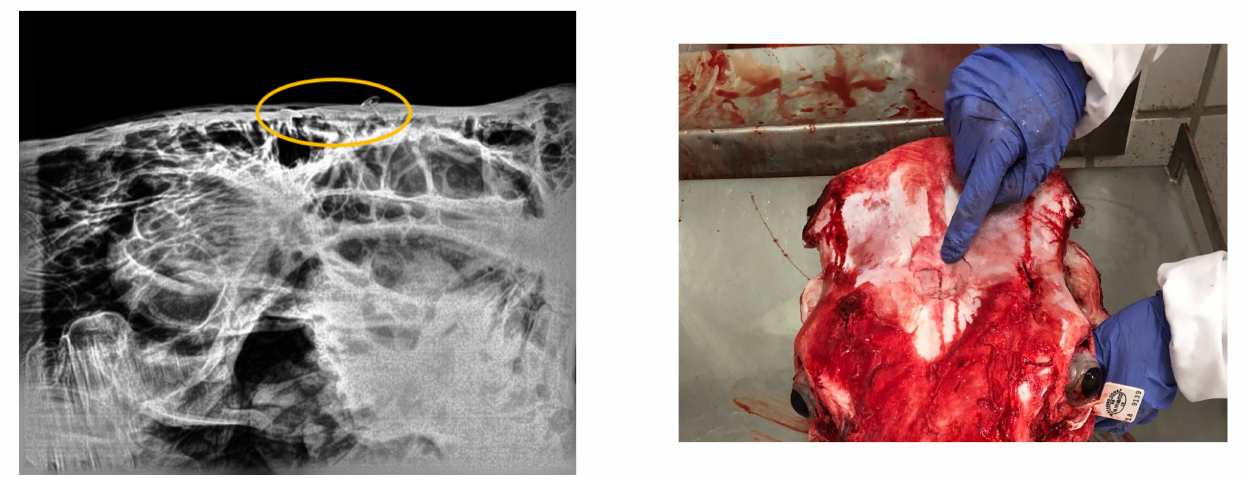
Figure 5. Digital radiography rating 3 (following Malaysia Standard 1500:2009). The eclipsed area defines the perimeter of the damaged area. On the right is shown the related